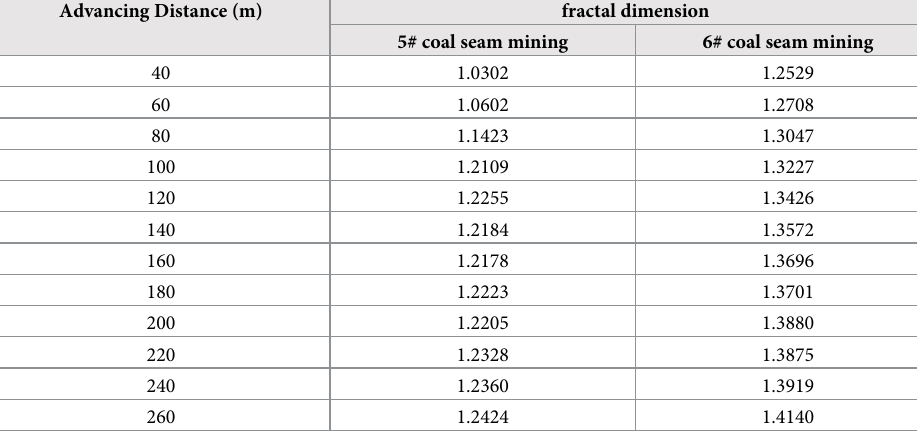
Table 5. Numerical similarity simulation of fractal dimension of overburden fissures after coal mining. Advancing Distance (m)